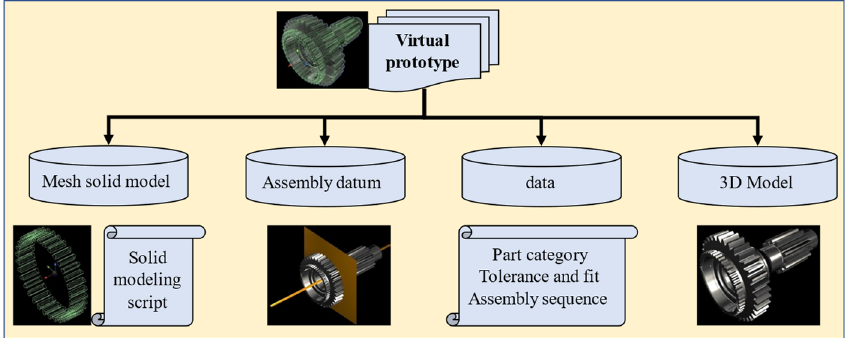
Figure 1. Virtual